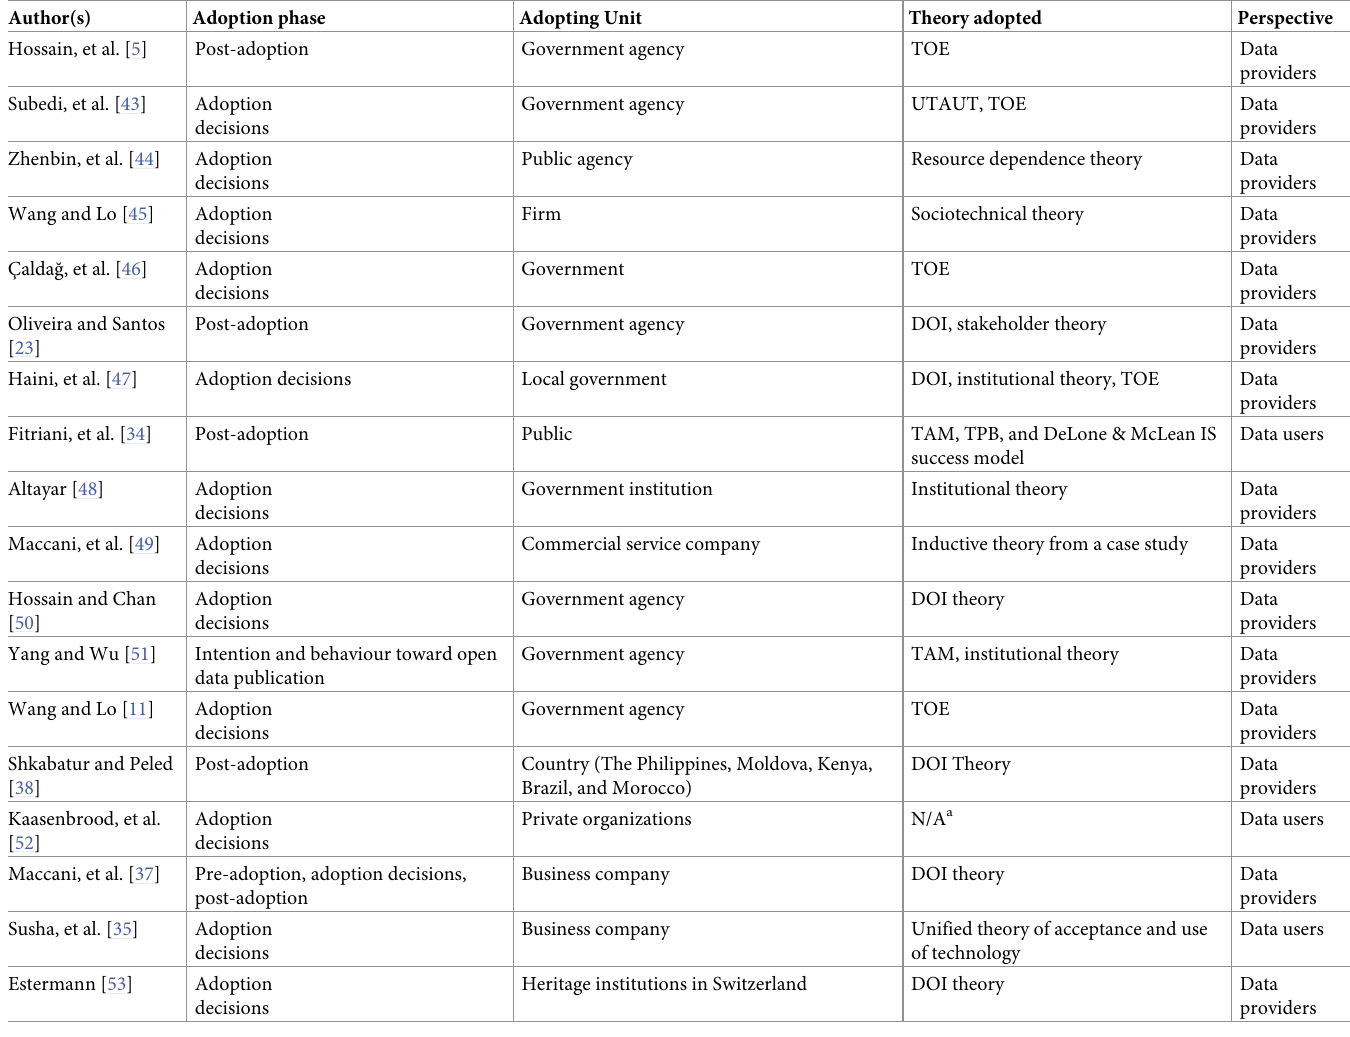
Table 1. Previous study on various OGD adoption